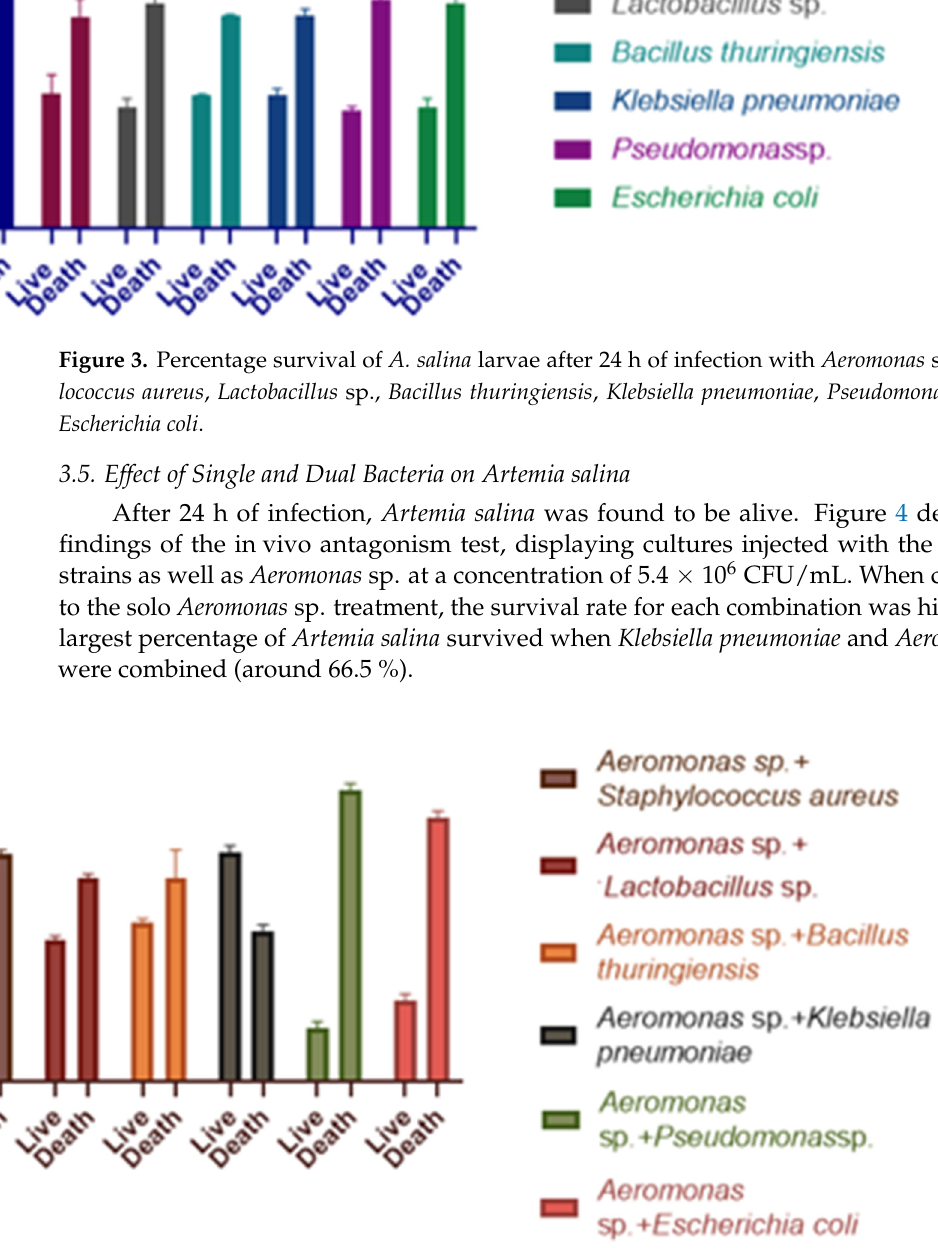
Figure 4. Percentage survival of A. salina larvae infected with two strains at a time. Here, Aeromonas sp. was used as a constant pathogen, and the other six were added to decipher the antagonistic effect. Data were recorded after 24 h of infection. Error bars represent standard deviation.